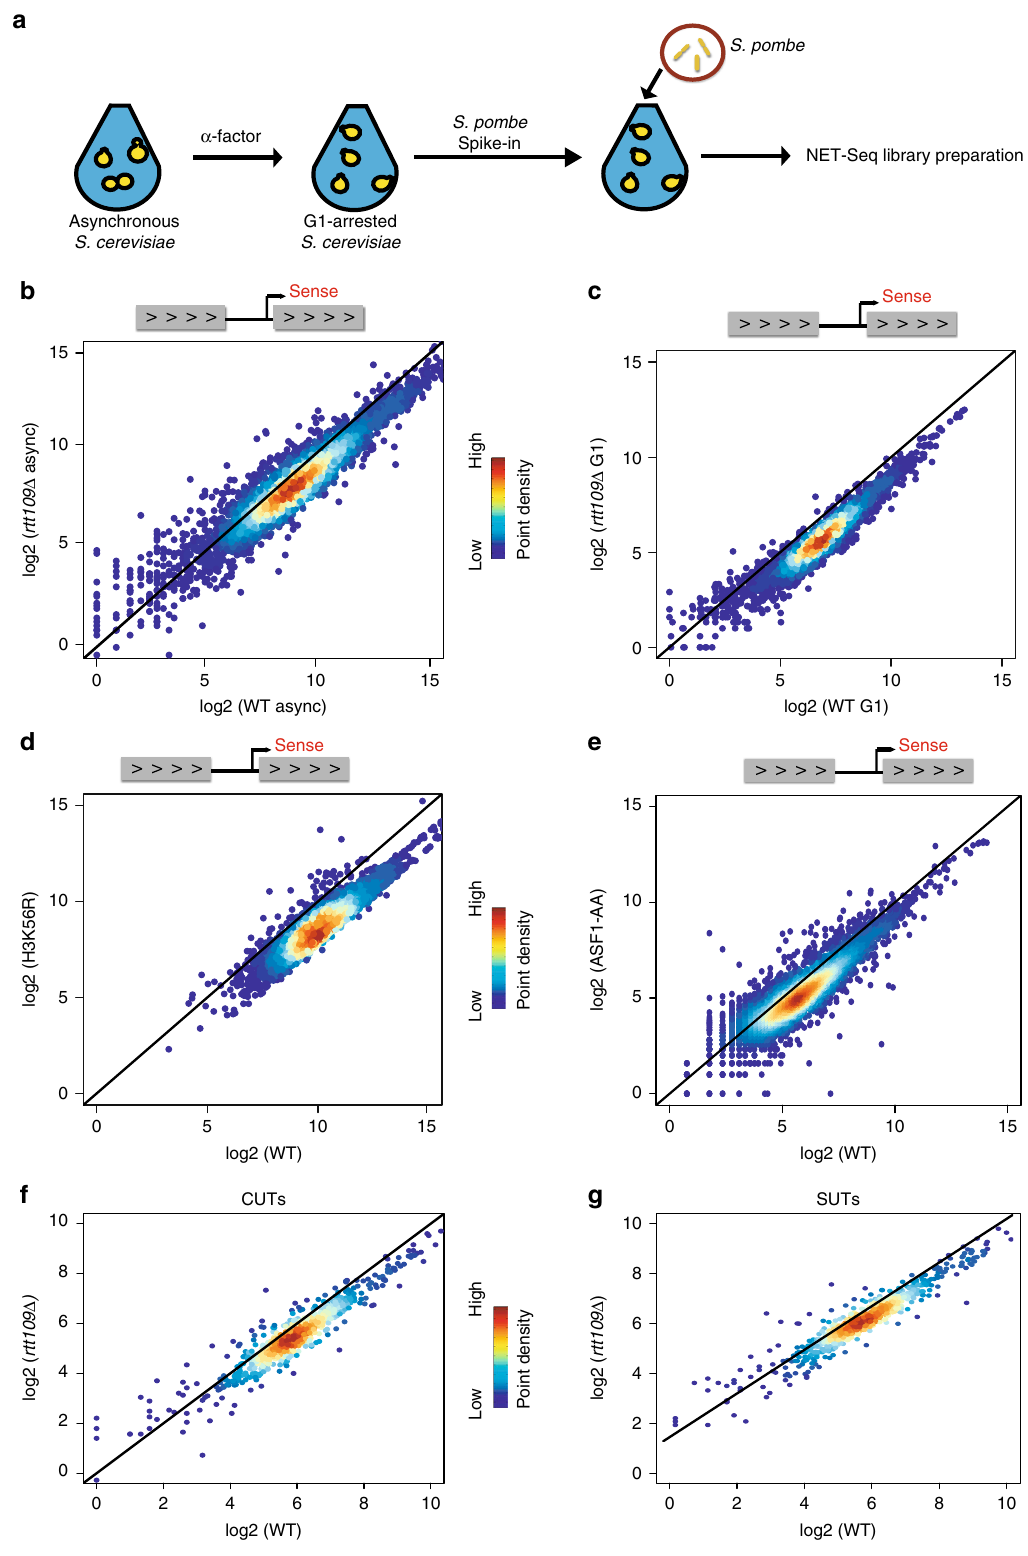
Fig. 1 H3-K56Ac globally activates transcription ( a ). Experimental design for NET-Seq. Unless indicated, cells were arrested in G1 by alpha factor ( α FT) for 1.5 h. Following the addition of control, S. pombe cells, nascent RNAs associated with RNAPII were isolated and sequenced. b – e NET-seq scatterplots showing log 2 mean intensity values for an average of two biological replicates ( n = 2) for all coding nascent transcripts ( N = 5302) between wild-type and mutant cells. b asynchronous WT and rtt109 Δ cells; c G1-arrested wild-type and rtt109 Δ cells; d G1-arrested WT and H3K56R cells; e conditional depletion of Asf1 for 1 h in G1-arrested cells (Asf1-AA), compared to WT; f nascent transcript levels for Cryptic Unstable RNAs (CUTs) between G1-arrested wild type and rtt109 Δ cells; g nascent transcript levels for Stable Unannotated RNAs (SUTs) between G1-arrested wild-type and rtt109 Δ